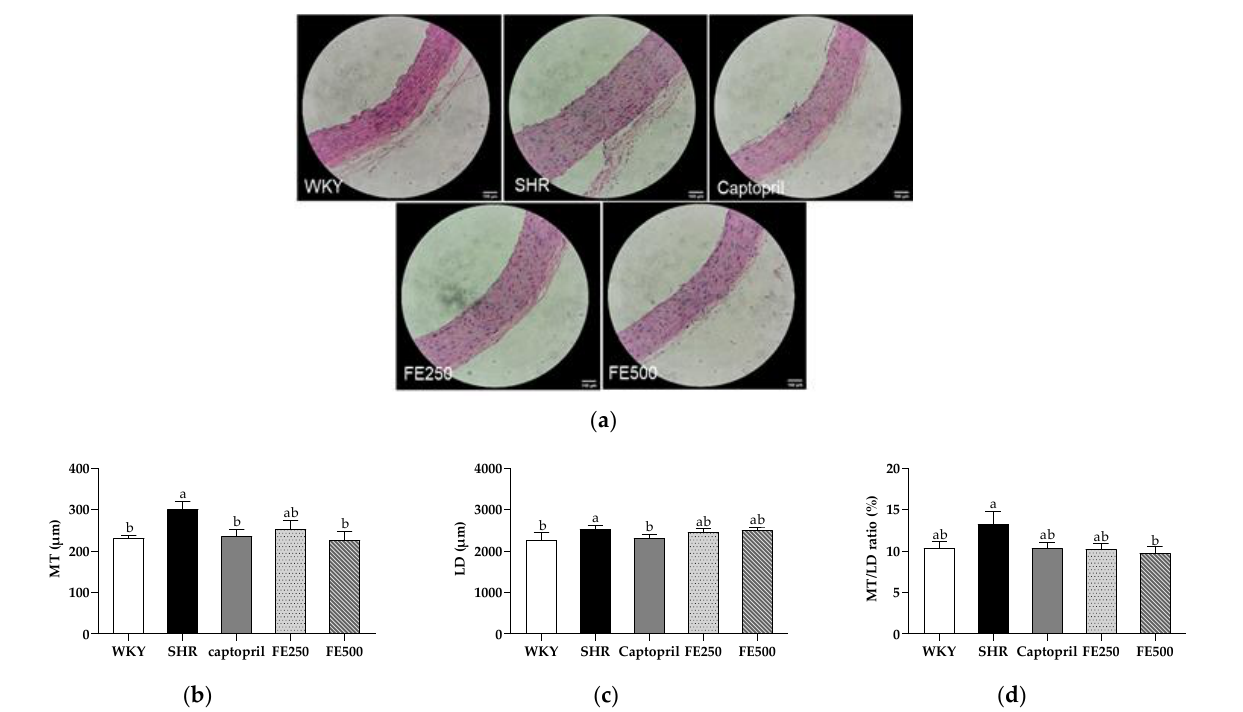
Figure 4. Effect of FE supplementation on aortic remodeling. ( a ) Histopathological changes in the aorta in each group were observed via hematoxylin and eosin staining; ( b ) The MT, ( c ) LD, and ( d ) MT/LD ratio were measured. MT, media thickness; LD, lumen diameter; WKY, Wistar Kyoto rats; SHR, Spontaneously hypertensive rats; Captopril, SHRs treated with 50 mg/kg bw of captopril; FE250, SHRs treated with 250 mg/kg bw of FE; FE500, SHRs treated with 500 mg/kg bw of FE; FE, finger millet ethanol extract. Data are expressed as means ± standard errors of the mean ( n = 6). Different letters above the bars indicate significant differences at p < 0.05.